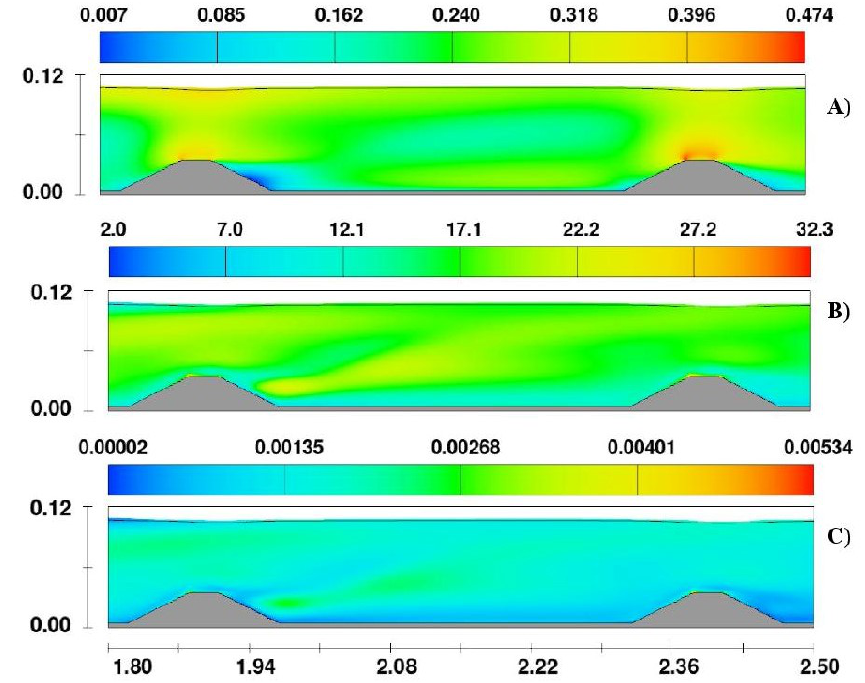
Figure 12. LES output in the XZ plane of the EZ (dim in meters) along the experimental zone of the ( A ) streamwise time-averaged velocities (m s − 1 ), ( B ) Turbulent intensities (%) and ( C ) TKE (m 2 s − 2 ).